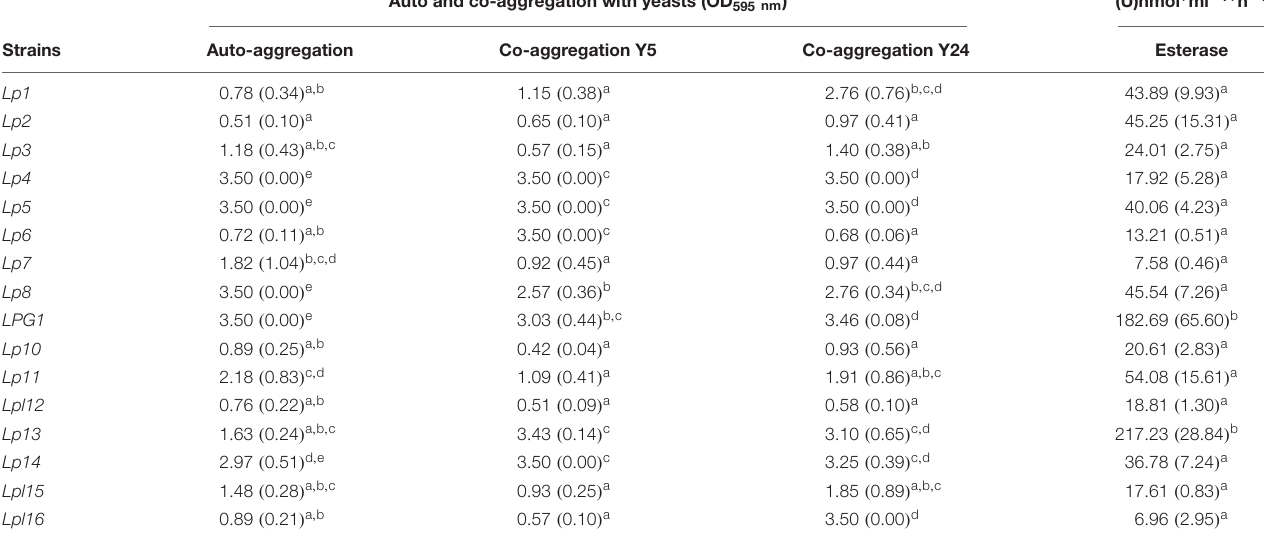
TABLE 2 | Technological characteristics for the 16 predominant LAB genotypes obtained in the present